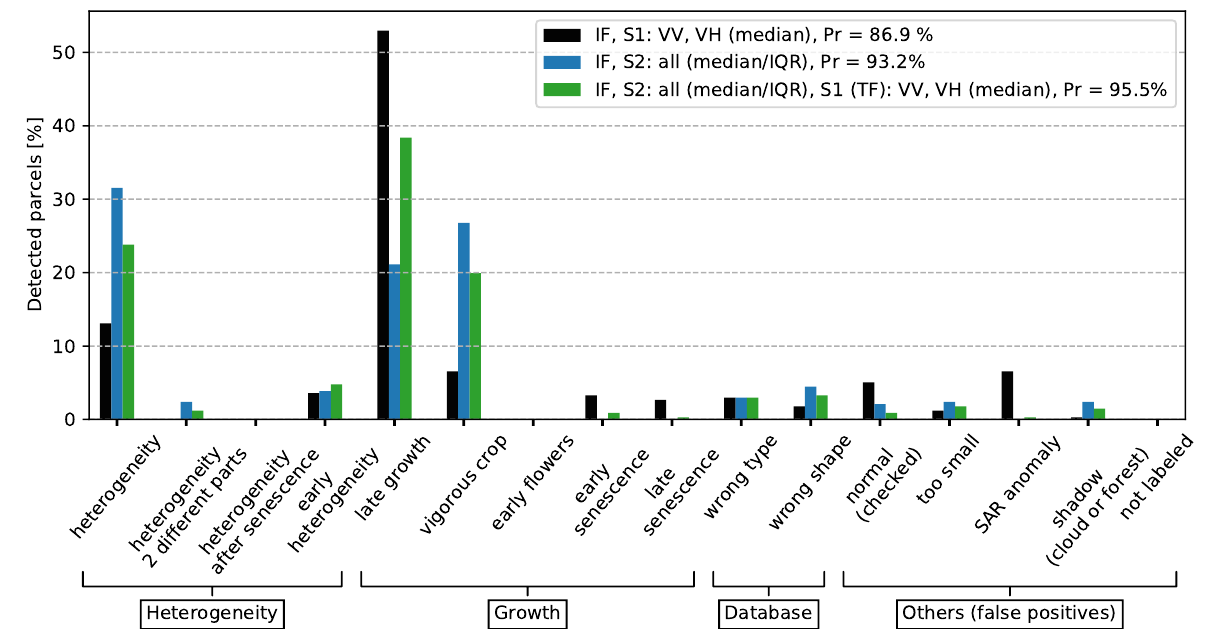
Figure 14. 100 × (Number of detected parcels in each category/Number of detected parcels). The analysis is conducted using wheat parcels with an outlier ratio equal to 10% and the IF algorithm. Black: S1 features only, blue: S2 features only, green: S1 and S2 features jointly. The precision (Pr) of the results for each feature set is added in the legend.